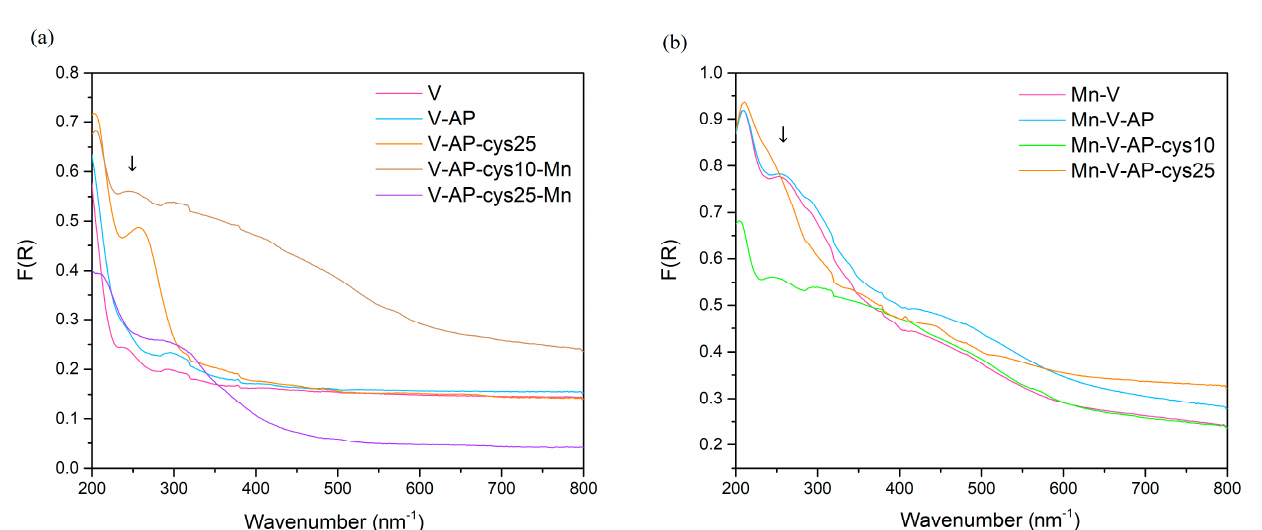
Table 1. Crystallite size of all vaterite materials.